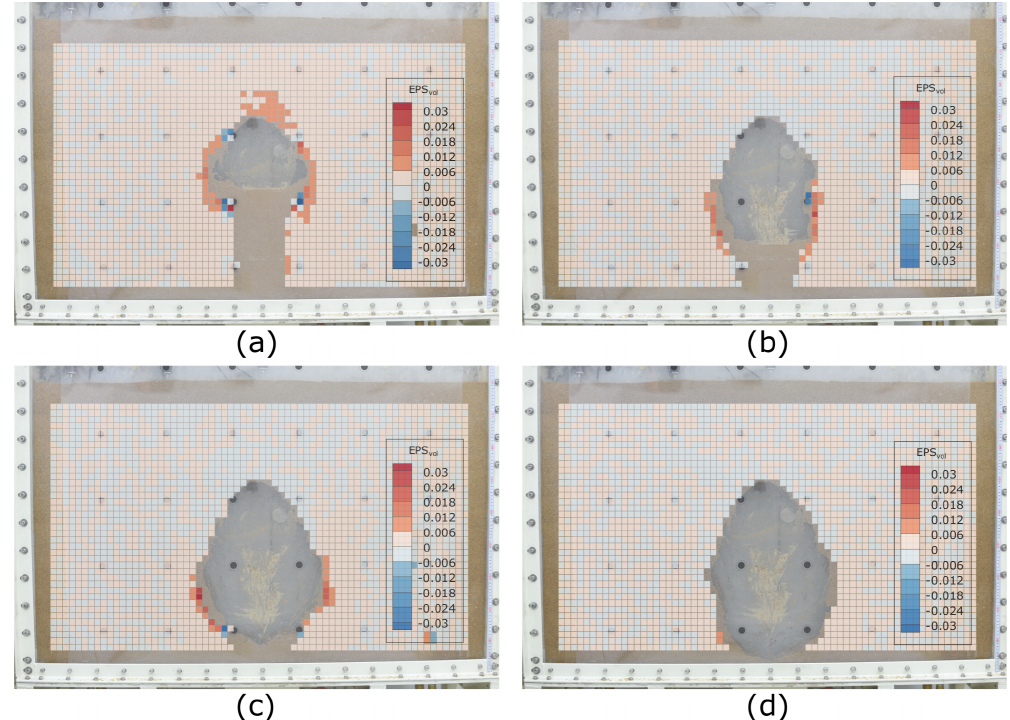
Figure 8. Volumetric strain inside the model ground for Test 2 during the water drainage stage: (a) 0–30s, (b) 30–60s, (c) 60–90s, and (d)